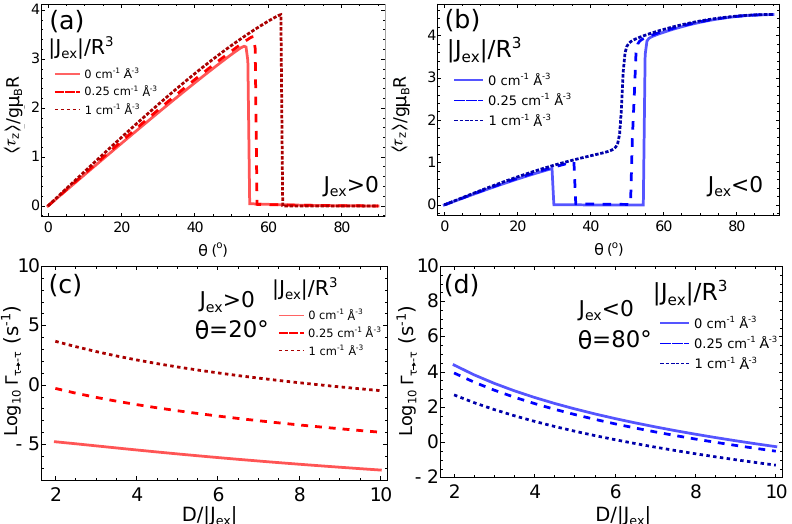
Figure 2. ( a , b ) Expectation value of the toroidal moment as a function of canting angle θ for the on-site S = 3/2 molecular triangle with a fixed ratio of | D / J ex | = 10 and ( a ) ferromagnetic and ( b ) antiferromagnetic exchange coupling. ( c , d ) Base 10 logarithm of the tunnelling rate between toroidal states in the molecular triangle induced by a stray magnetic dipole. ( c ) Tunnelling rates in the ferromagnetically coupled triangle with magnetic axis canting angle θ = 20 ◦ . ( d ) Tunnelling rates in the antiferromagnetically coupled triangle with magnetic axis canting angle θ = 80 ◦ . The effect of intramolecular magnetic dipole–dipole coupling between paramagnetic ions in the SMT on the stray-dipole-assisted tunnelling rate is highlighted by vanishing (solid line), intermediate (dashed line) and strong (fine dashed line) intramolecular dipole–dipole